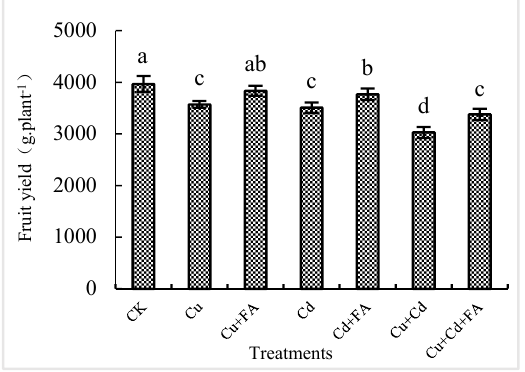
Figure 2. Spraying FA promoted fruit yield of tomato under different Cu, Cd treatments. The same alphabet above each column shows no significance ( p > 0.05), in contrast, having significance ( p < 0.05). 3.3. Effects of Spraying FA on Cu and Cd Contents in Tomato Fruit under Different Cu, Cd Stress The application of FA significantly reduced the content of Cu and Cd in tomato fruit under stress. Compared with CK, the Cu content of tomato fruit treated with T1 (Cu) and T5 (Cu + Cd) increased significantly, by 41.1% and 360%, respectively (Figure 3A). In T5 (Cu + Cd) treatment, the addition of Cd promoted the absorption and transport of Cu in tomato under Cu stress. In T2 (Cu + FA) and T6 (Cu + Cd + FA) treatments, spraying FA significantly reduced the Cu content of tomato fruit, with a decrease of 13.1% and 57.7%, compared with stress conditions,